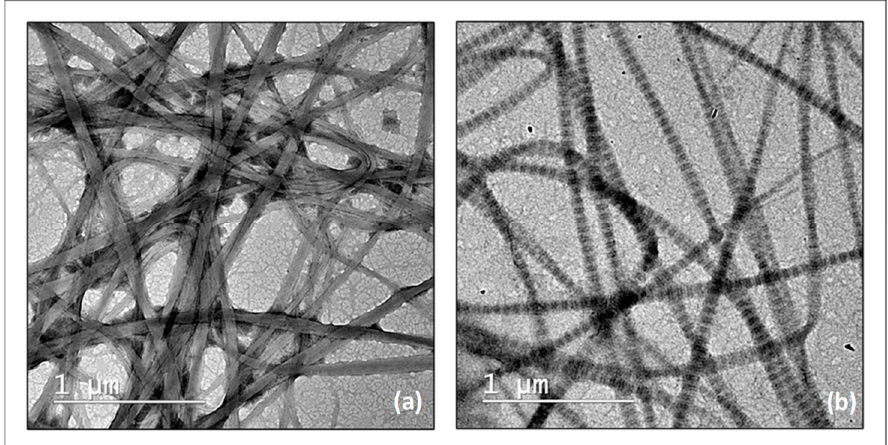
Figure 3. STEM images for collagen fibrils in the absence ( a ) and presence ( b ) of riboflavin, pH 7.5. Rheological measurements and STEM investigation evidenced that both riboflavin and hyaluronic acid influence the fibrillogenesis of collagen. We further investigated by microDSC measurements the effect of riboflavin, hyaluronic acid, and UVA exposure of collagen samples on the thermal stability of the protein assemblies.